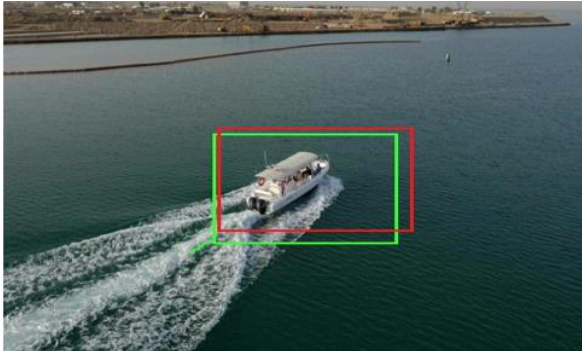
Figure 8. Training LSTM